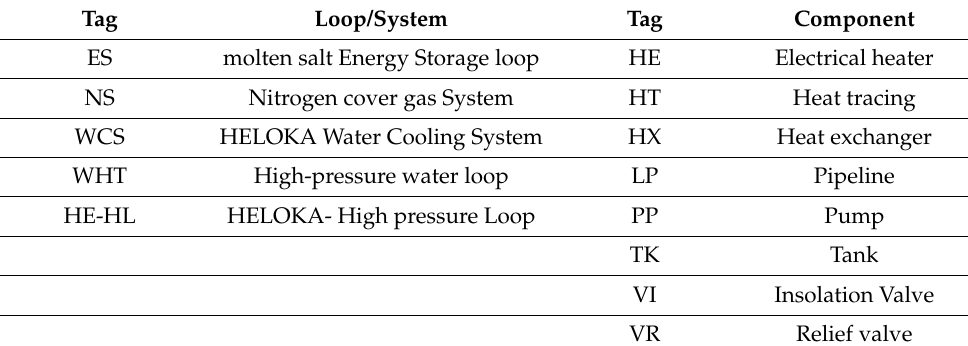
Table 1. Tags of loops/system and tags of component in HELOKA-US.